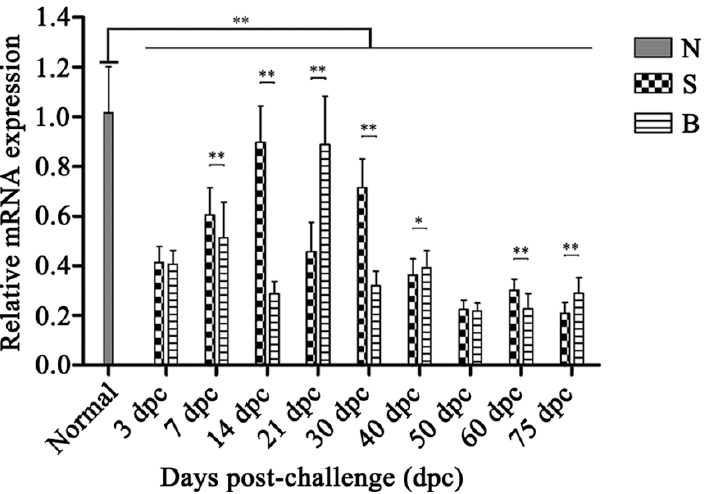
Figure 8. Differential expression of OaLypla1 from buffy coats of O. aries challenged with different virulent Brucella strains. N: the normal sheep group; S: the group inoculated with the avirulent Brucella suis S2 strain; and B: the group challenged with the virulent field strain Brucella melitensis . Relative expression was calculated by the 2 −∆∆ C t method using O. aries β -actin as an endogenous control. Statistical differences among the groups were determined by a one-way analysis of variance (ANOVA) using SPSS 13.0 software. Data are presented as the mean relative expression ± SD ( n = 3) (* p < 0.05, ** p < 0.01).